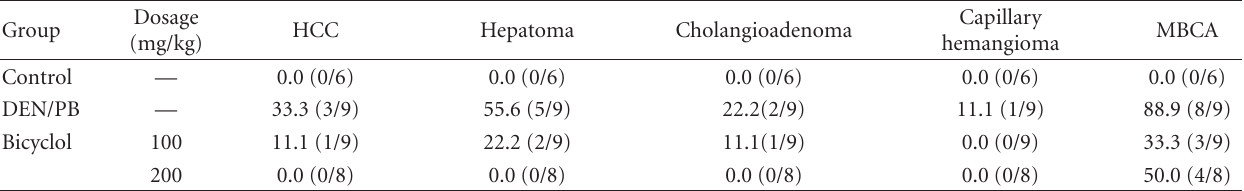
Figure 2: Gross liver tumor and nodule phenotypes in DEN/PB-induced ICR mice and the preventive e ff ect of bicyclol at week 20. (a) Photographs of representative livers. (b) Determination of liver tumor and number of nodules per liver greater than approximately 1mm in diameter. Average values with standard deviations are shown. n = 8–10. ## P < 0 . 01 compared with the control group; ∗ P < 0 . 01, ∗∗ P < 0 . 01 compared with the DEN/PB model group. Table 1: The incidence of liver tumors induced by DEN/PB in mice and the e ff ect of bicyclol determined by H&E staining and histological